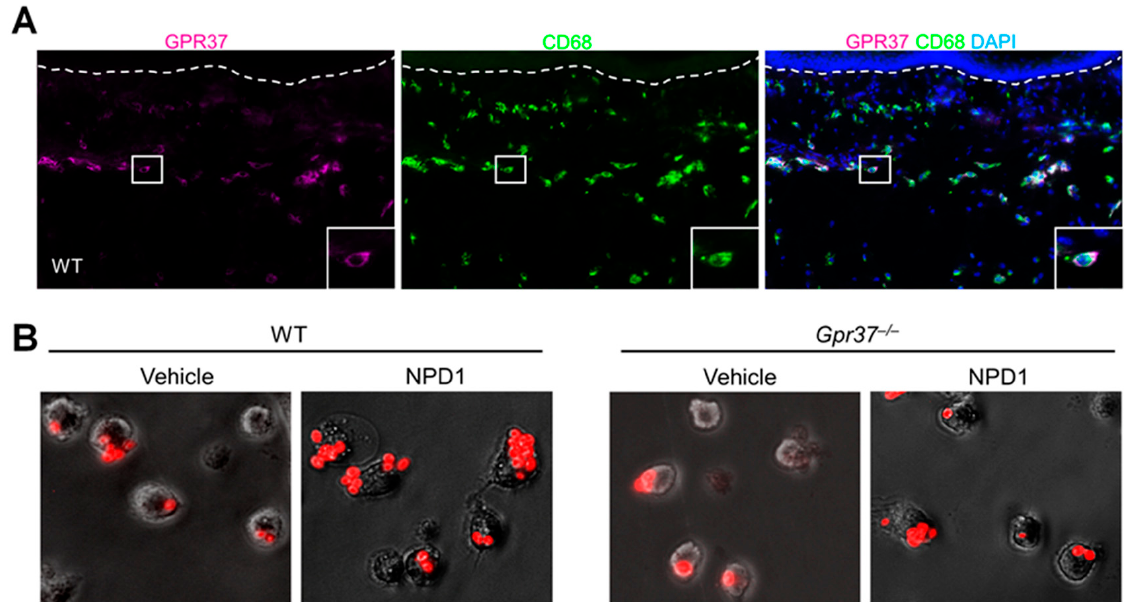
Figure 2. GPR37 expression in macrophages promotes macrophage phagocytosis. ( A ) Immunohistochemistry reveals the co-expression of GPR37 with activated macrophage marker CD68 in the dermis of hindpaw skin of WT mice. ( B ) Macrophage phagocytosis of zymosan particles. NPD1 enhanced phagocytosis of zymosan particles in WT peritoneal macrophages. NPD1-induced macrophage phagocytosis is diminished in Gpr37 − / − mice. There figures are reproduced from Bang et al., JCI, 2018 with permission